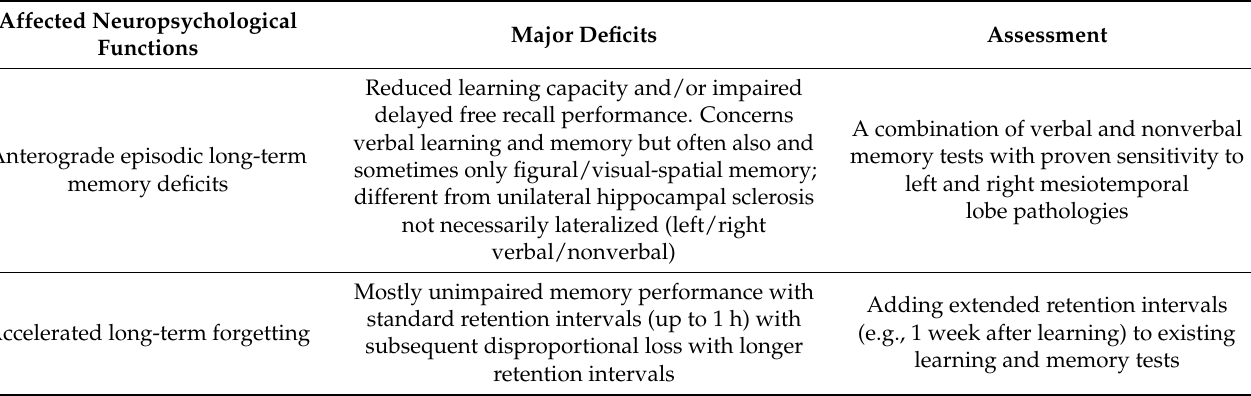
Table 1. Overview of cognitive and behavioral problems in limbic encephalitis and approaches to assess them. Affected Neuropsychological Major Deficits Assessment Functions